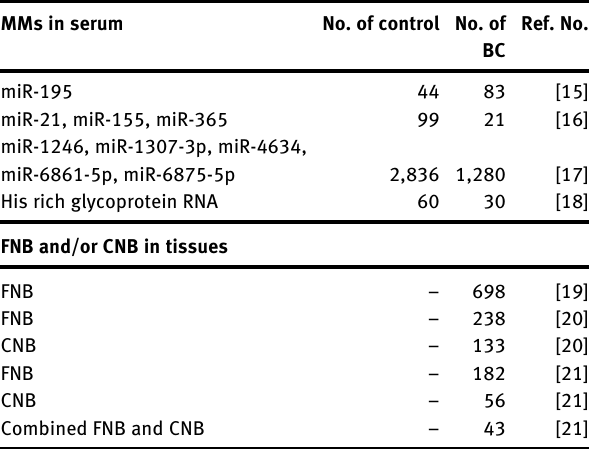
Table  : Data reported in literature for serum MMs and for invasive FNB and CNB methods in BC patients.